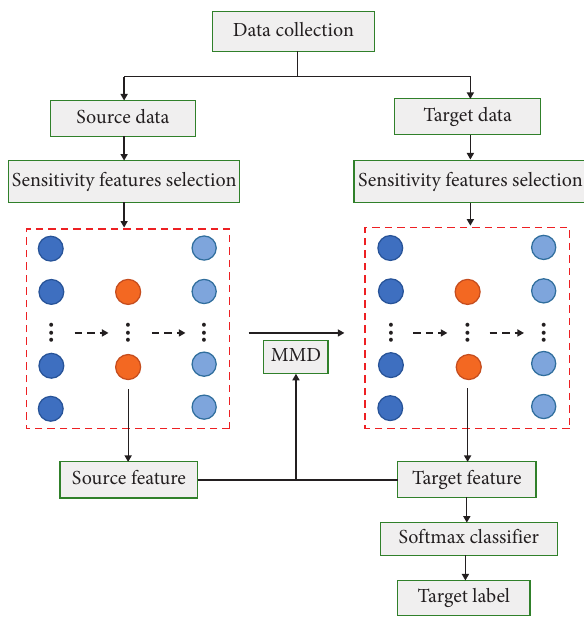
Figure 2: The architecture of the proposed